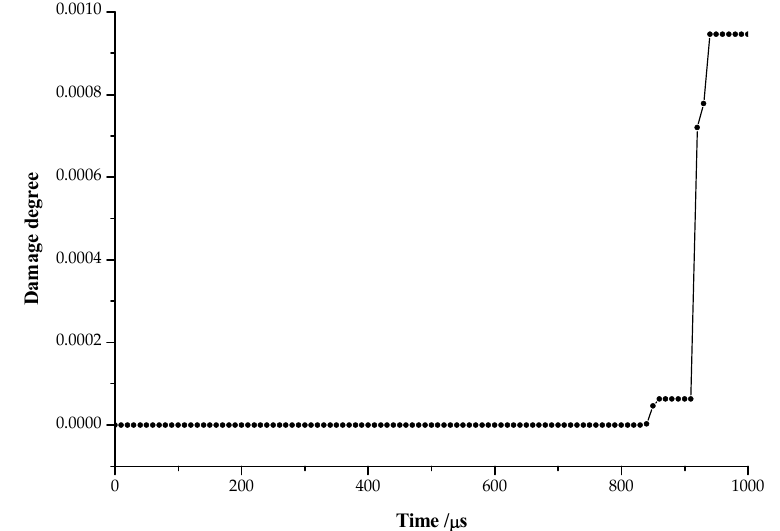
Figure 10. Damage degree–time curves for monitoring point 2.